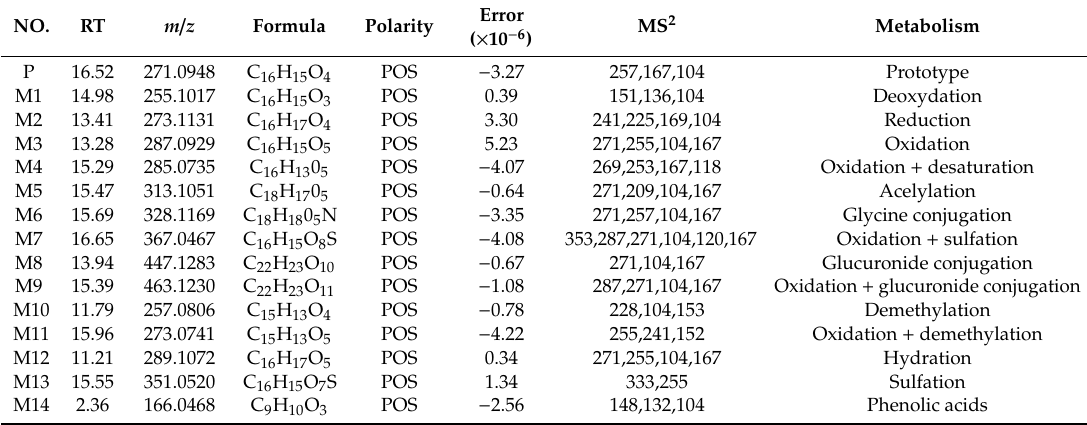
Table 1. Mass spectral data of alpinetin (P) and its metabolites